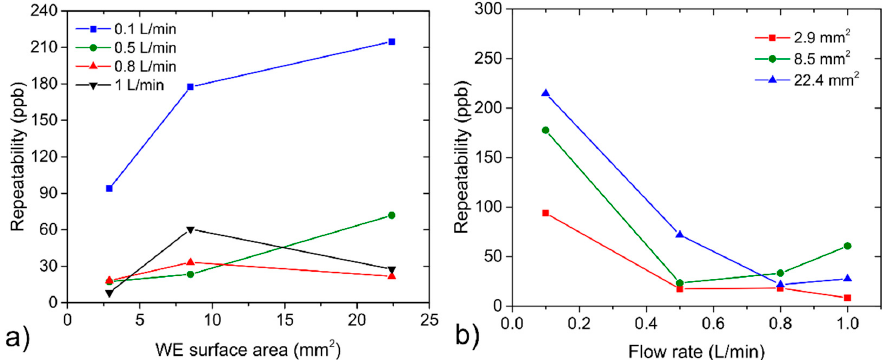
Figure 10. ( a ) Repeatability dependence on the WE surface area, ( b ) repeatability dependence on the analyte flow